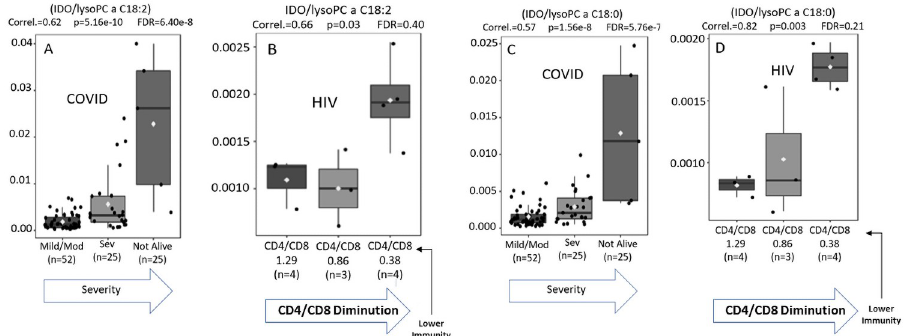
Fig 6. (A-D). Comparison of immune signatures for Covid 19 vs. HIV using immune IDO (Kyn/Trp) ratio divided by the inflammatory markers (lyso PC a 18:2 and 18:0) correlates Covid 19 severity with HIV progression.